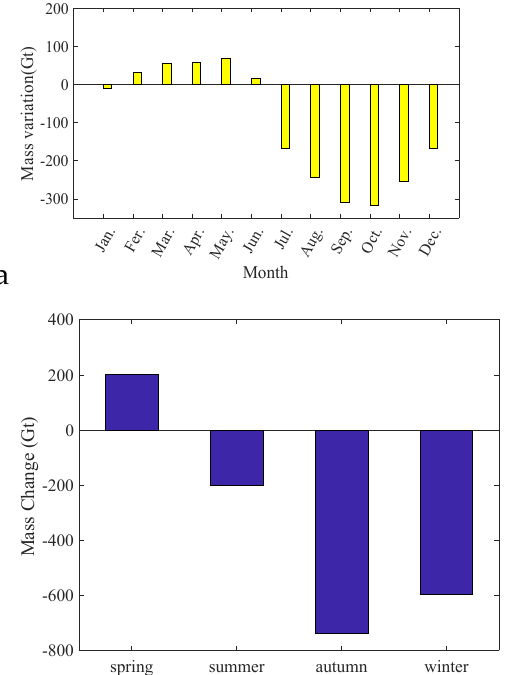
Figure 6. GrIS: ( a ) monthly and ( b ) seasonal mass variations estimated based on averaging the GRACE monthly solutions from four processing centers between April 2002 and June 2017 and after applying the forward modeling technique to suppress the ocean-land leakage effect. The values represent the monthly and seasonal average over the investigated period.